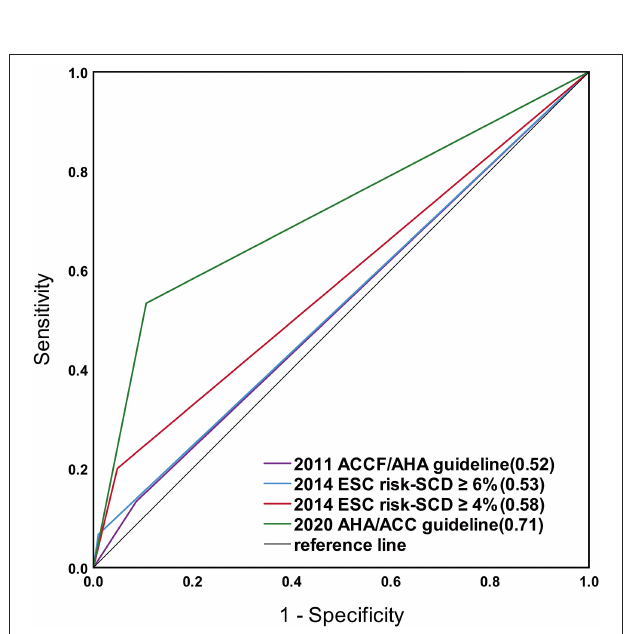
FIGURE 2 | Receiver operating characteristic (ROC) curves for the risk prediction models of the 2011 ACCF/AHA, the 2020 AHA/ACC guidelines, and the 2014 ESC guideline with a cut-off level of 4 and 6%. The sudden cardiac death (SCD) risk stratification in the 2020 AHA/ACC guideline showed greater area under the curve (0.71) than the